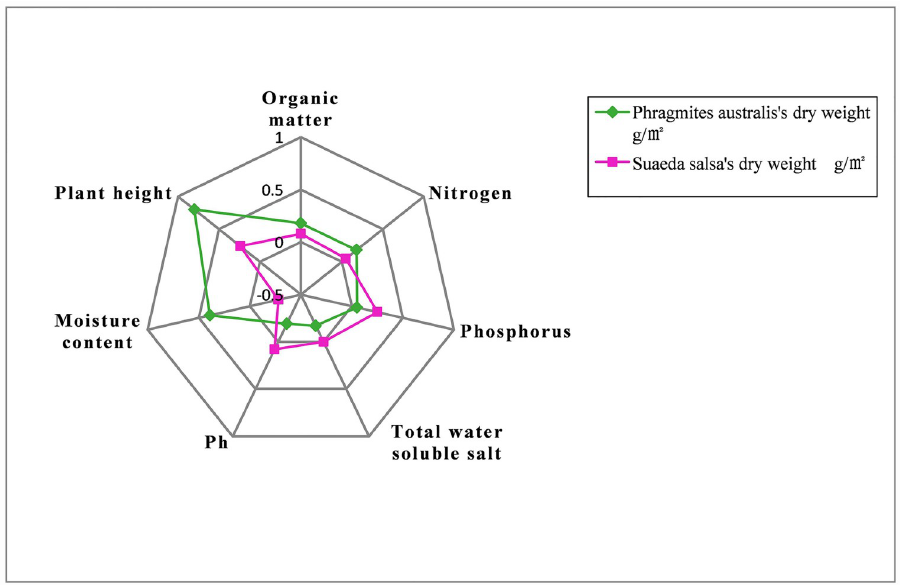
Fig 3. Radial map of the correlation coefficient of two vegetative species and selected environmental factors in the Yellow River Delta Nature Reserve wetlands.